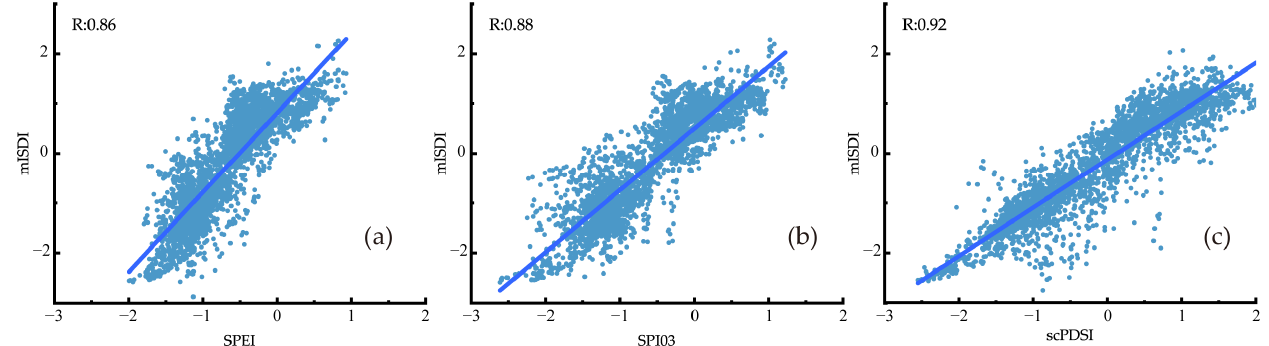
Figure 6. Correlation analysis of three drought indices and the mISDI: ( a ) correlation analysis of the SPEI and the mISDI; ( b ) correlation analysis of the SPI03 and the mISDI; ( c ) correlation analysis of the scPDSI and the mISDI.